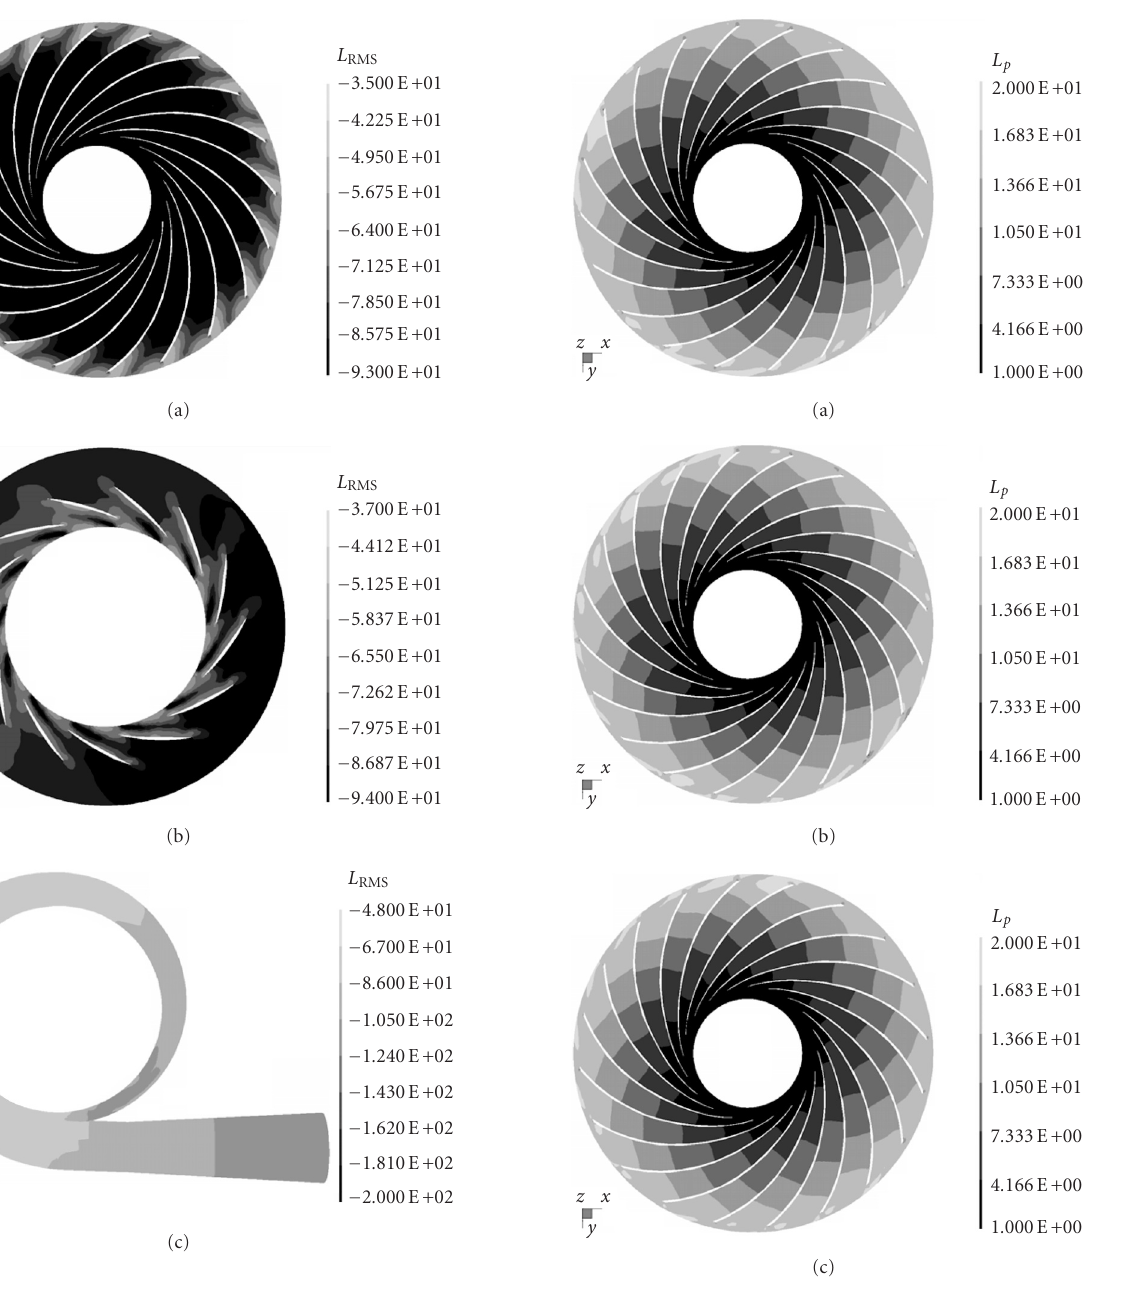
Figure 10: Variance of pressure level in the vaned case at design Figure 11: Static pressure distribution on impeller center plane in conditions: (a) impeller center plane, (b) di ff user center plane, and the vaneless di ff user at design conditions: (a) starting position, (b) (c) volute surface. 1 / 3 revolution, and (c) 2 / 3 Table 2: Unsteadiness degree of impeller. Impeller Parameter Vanless Vaned D (%) 0 − 82 . 27